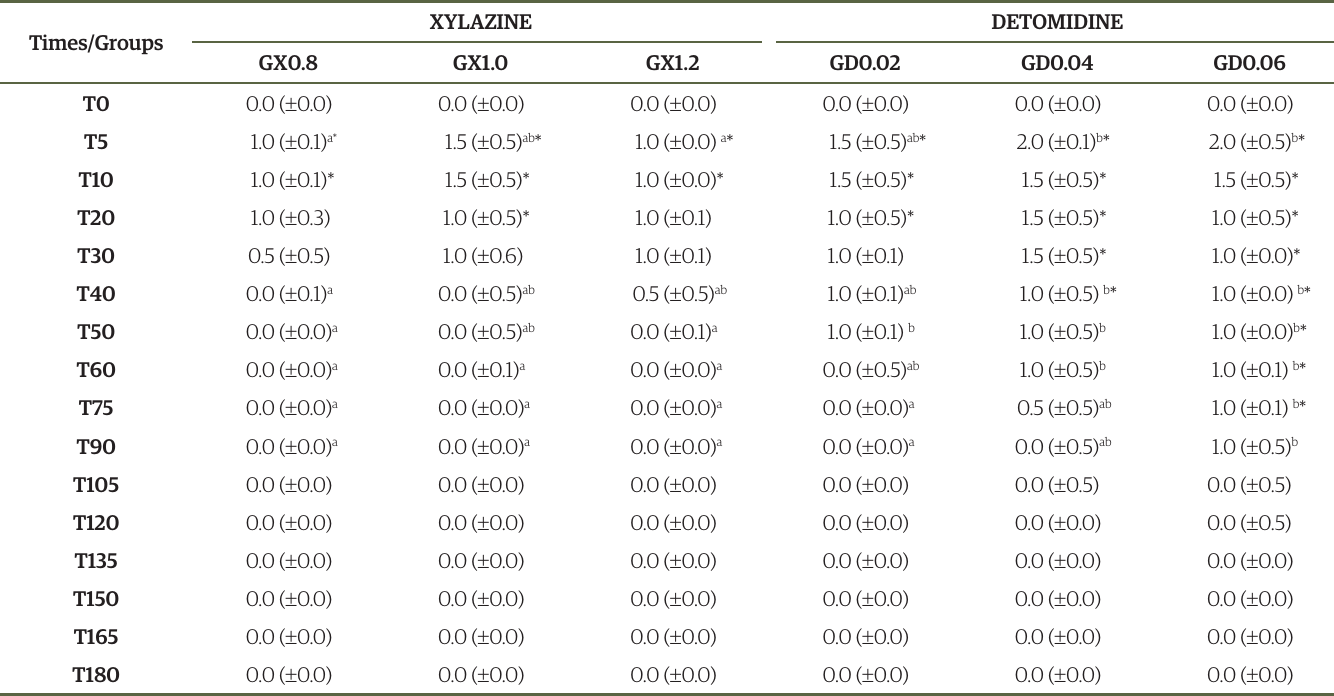
a, b, ab = different letters indicate a significant difference between groups at each moment (p<0.05). * = significant difference for the moment compared to T0 (p<0.05).